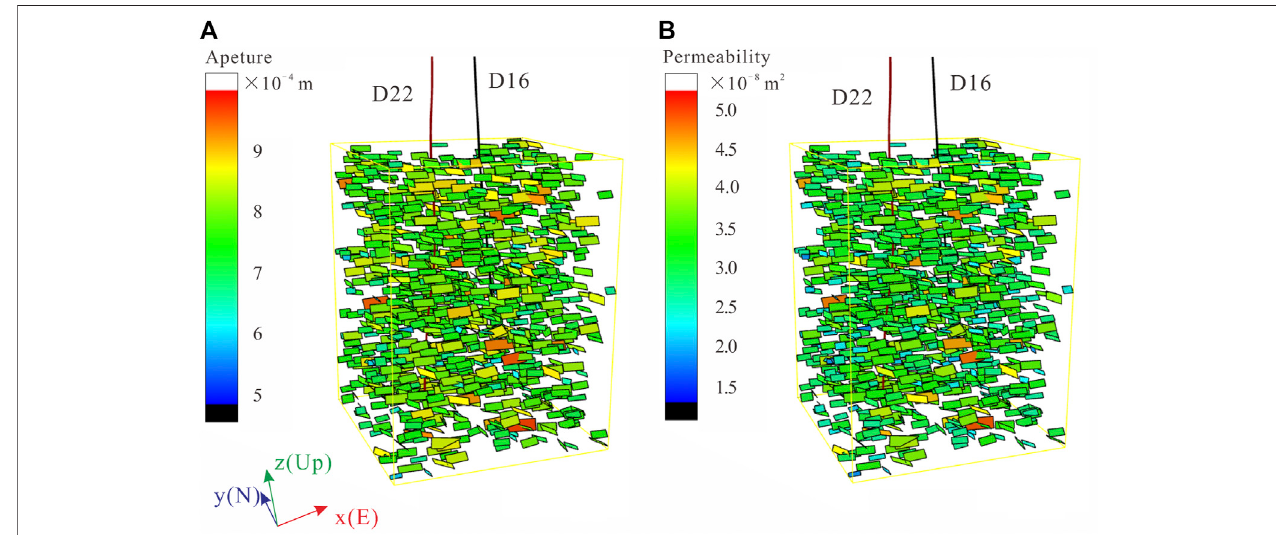
FIGURE 7 | (A) Distribution of the fracture aperture, and (B) permeability for the 3D DFN model.